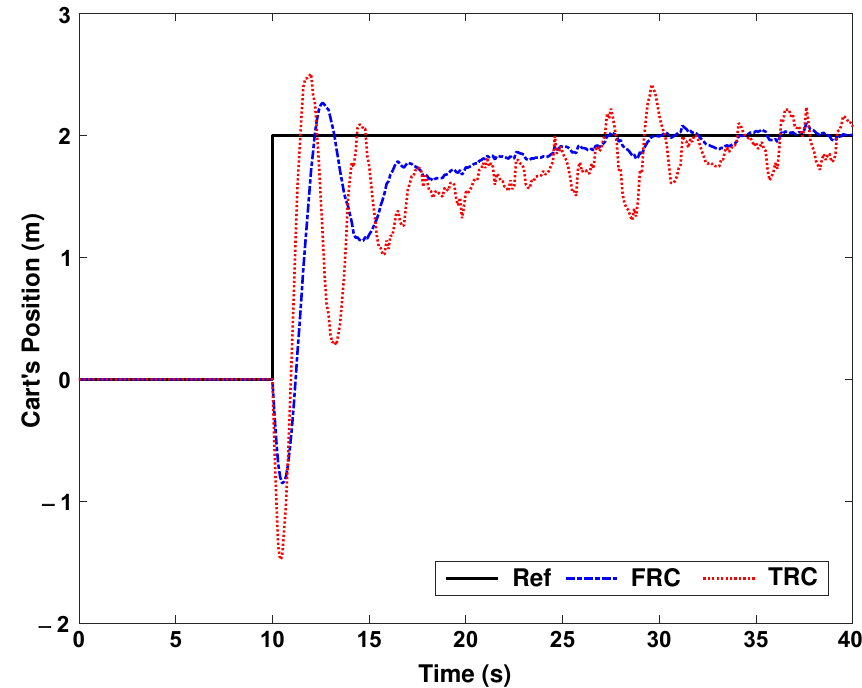
Figure 14. Cart position control despite parametric